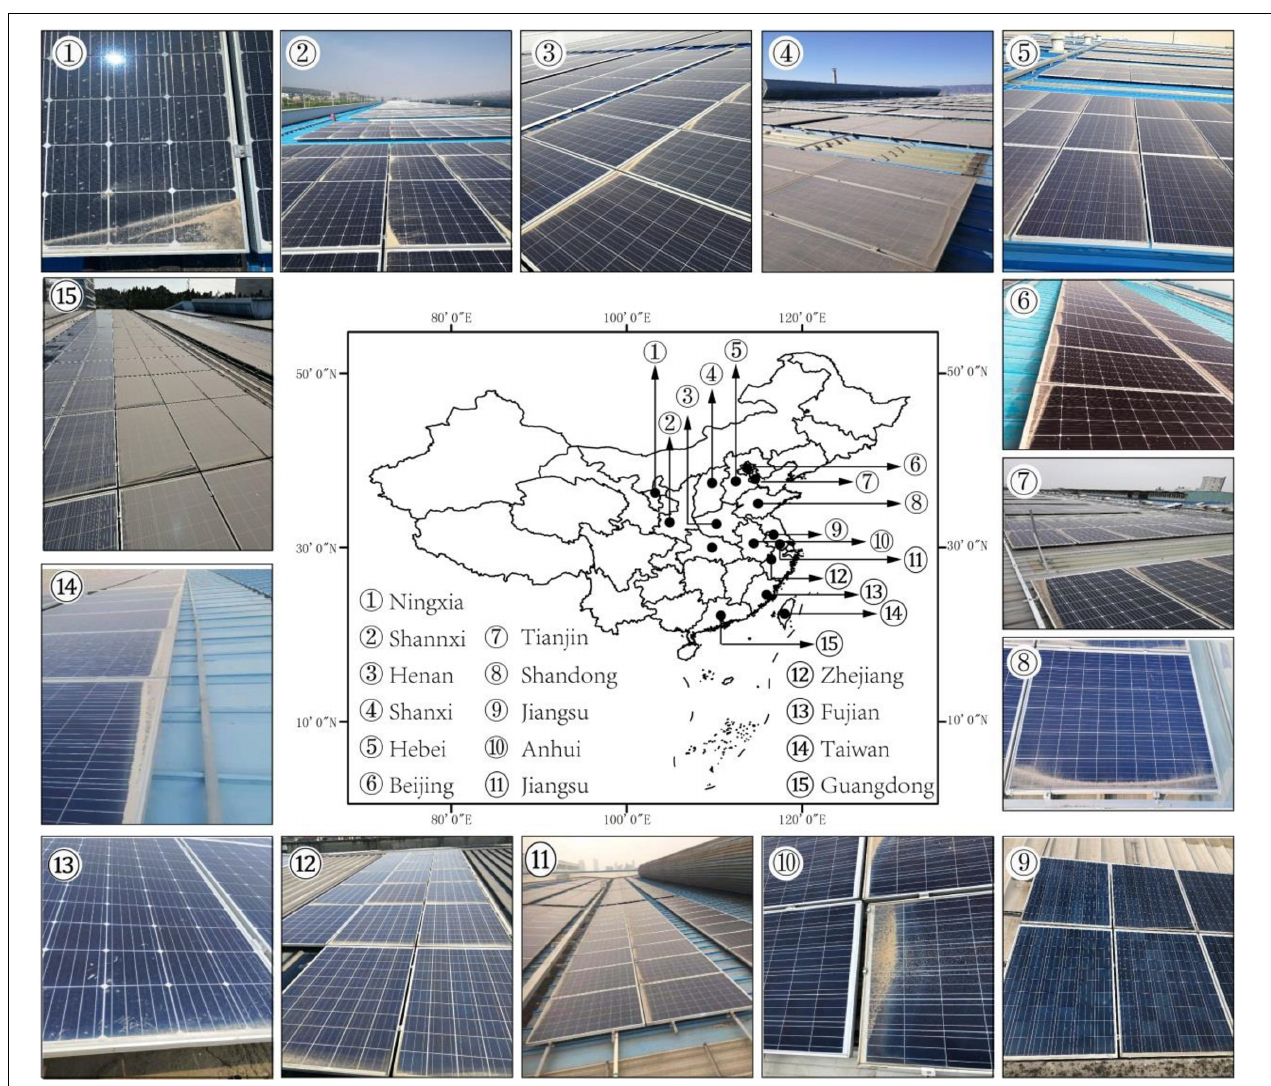
FIGURE 1 | Photographs of soiling bands on industrial and commercial metal rooftop PV power stations in several provinces in central and eastern China from 2018 to